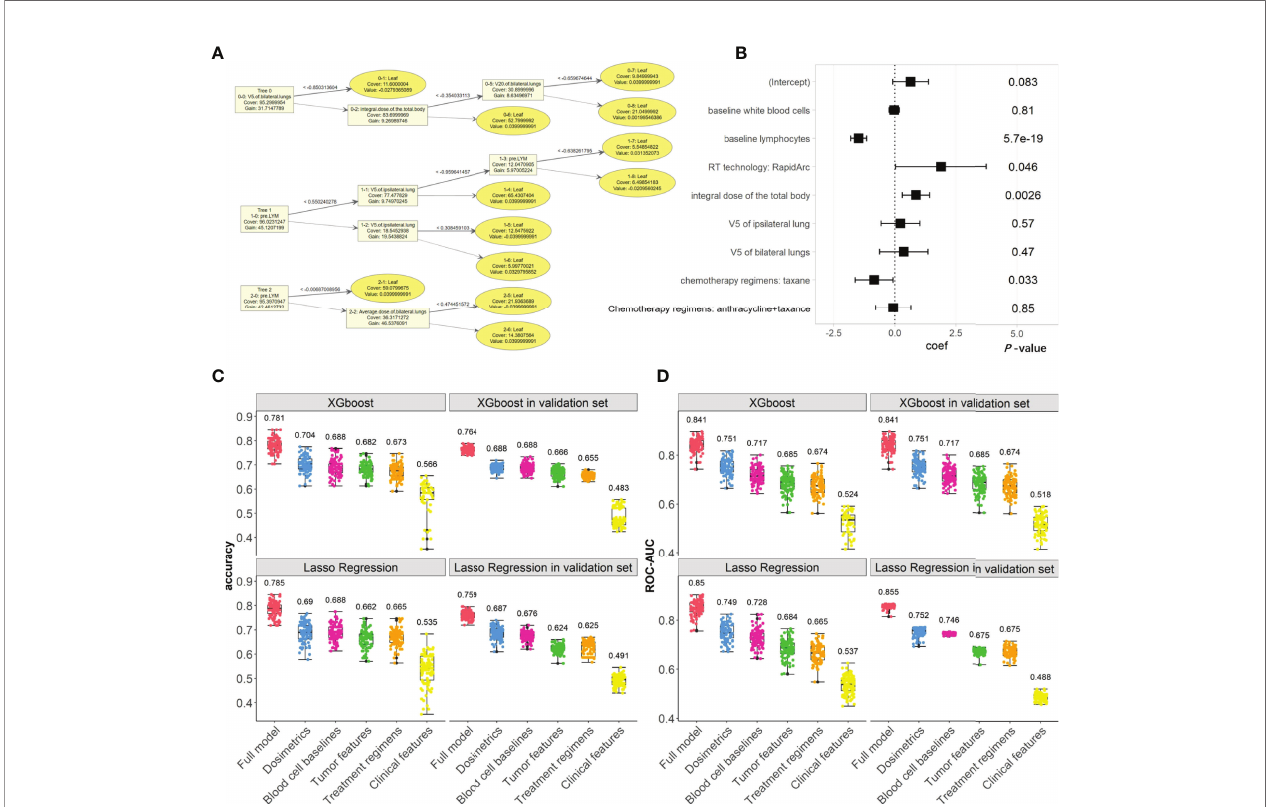
FIGURE 2 | The XGboost and Lasso regression models for predicting the radiation-induced lymphopenia were trained in Testing cohort and validated in Validation cohort. (A) The top two trees in one example of XGboost model; (B) coef fi cients and P -values in one example of Lasso regression; (C, D) the classifying performances (accuracy and ROC-AUC, respectively) of XGboost models across all iterations in Testing cohort and in Validation cohort, compared with the Lasso regressions. In subplots (C, D) , numerical labels are median values. The color represents the feature ’ s group, including: the full model (Orange), dosimetrics (blue), blood cell baselines (maroon), tumor features (green), Treatment regimens (Khaki), clinical features